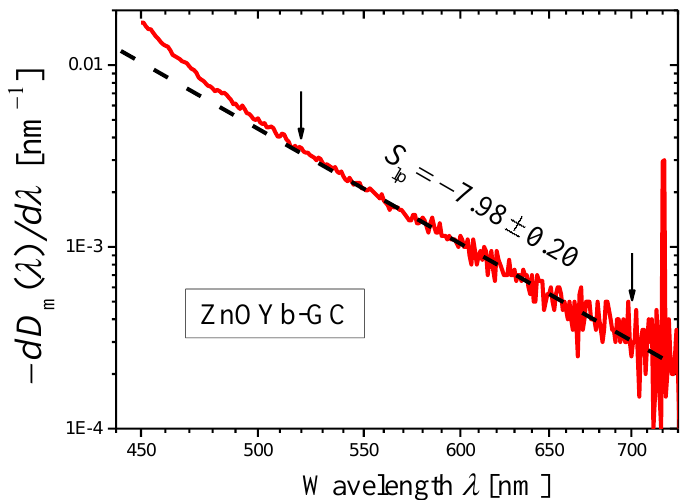
Figure 9. A log–log plot of the dependence of ( − dD i m ( λ ) / d λ ) on λ (red curve) constructed for the measured optical density D m ( λ ) of sample of the glass-ceramic ZnOYb-GC with the thickness h = 3.02 mm. The portion of the curve limited by arrows is approximated by a black dashed straight line using the least squares method, and the slope 𝑆 lp of the straight line is indicated in the figure.